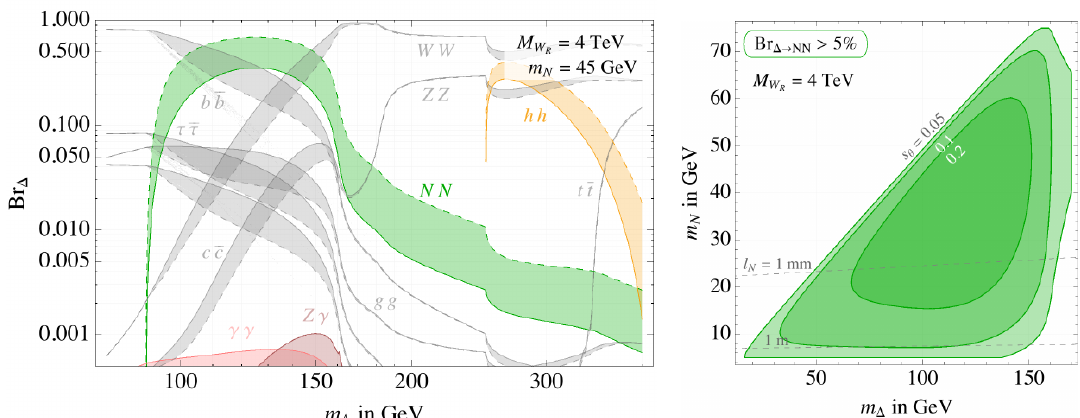
Figure 1 . Left: branching ratios of (cid:1) to a pair of Majorana neutrinos (green) with m N = 45 GeV, pairs of Higgses (red) and other SM particles in grey, (cid:13)(cid:13) in pink and Z(cid:13) in purple. The shaded areas cover the variation of s (cid:18) from 5% in dashed lines to 10% in solid ones. Right: regions of appreciable branching ratio to N (Br (cid:1) ! NN > 5 %) for s (cid:18) = 5 ; 10 and 20%; in both cases M W (cid:12)xed at 4 TeV, m H = 17 TeV and r ++ = 0 : 3 (see appendix). The dashed lines show the lifetime of N in the lab frame, taking into account the mean boost of N at